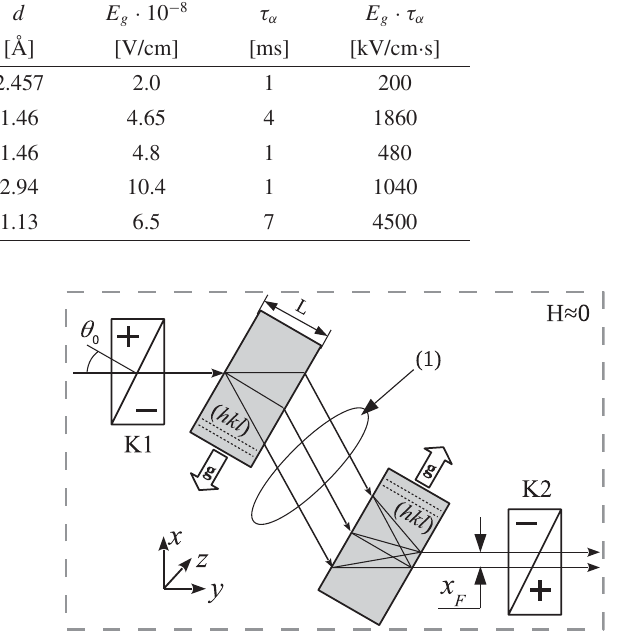
Figure 4. Idea of the experiment using neutron Laue diffraction. K1, K2 are the coils with the magnetic field B , the signs “ + ” and “ – ” correspond to the directions of the magnetic